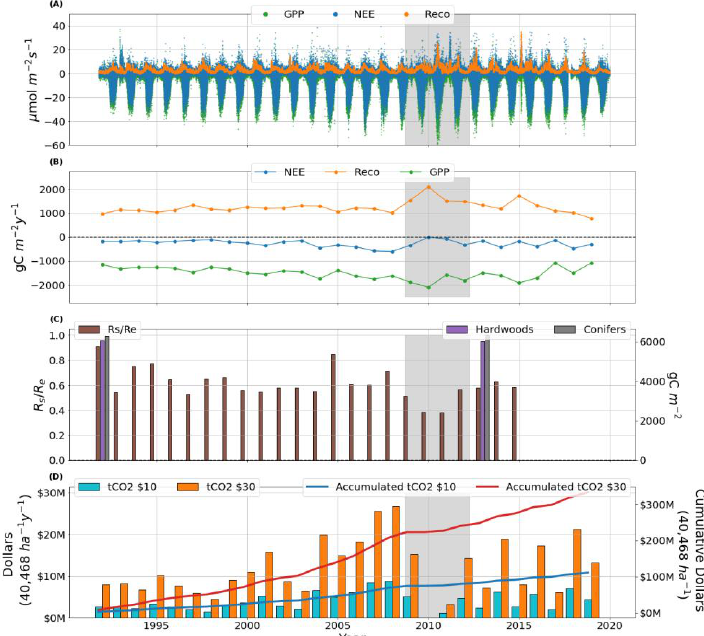
Figure 1. (A) Hourly NEE (blue), GPP (green), and R eco (orange) for the period 1992 to 2019. (B) Same as (A) shown as yearly sums. (C) Soil respiration (R s ) divided by Ecosystem Respiration (R e ) yearly values (Brown) and total soil carbon measured in the top 15 cm of the mineral soil of the hardwood- (purple) and conifer- (grey) dominated plots from [6]. (D) CO 2 yearly sequestration value in U.S dollars ($) assuming a ton of CO 2 were worth $10 (light blue bars) or $30 (orange bars), and their accumulated values (blue and red lines respectively) extrapolated to 40,468 ha (100,000 acres), based solely on numerical projection to illustrate potential project revenue with increasing land area, assuming there were no exits during the interval 1992–2019. Further details of this calculation are available in Appendix A. The period 2009–2012 is highlighted with a grey shade to illustrate status of variables resulting in large financial loss for the interval. Referring to Figure 1D, pre-tax, gross income from the Harvard Forest for the total period of data would be over $109 million, or over $329 million for a price of $30 tCO 2 . Additional data for the daily and seasonal NEE, GPP and R eco behavior can be found in Appendix A (Figure A1, hourly and yearly NEE; Figure A2, Annual and weekly histo- grams for NEE, R eco and GPP; Figure A3, annual and monthly R eco versus GPP, and Table A1 for yearly statistics) and online: https://pemcarbon.com/ecaas/.